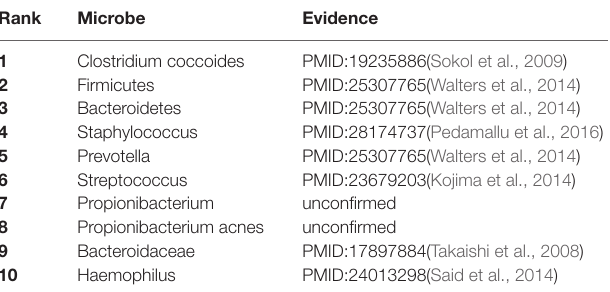
TABle 4 | Top 10 potential IBD-related microbes predicted by